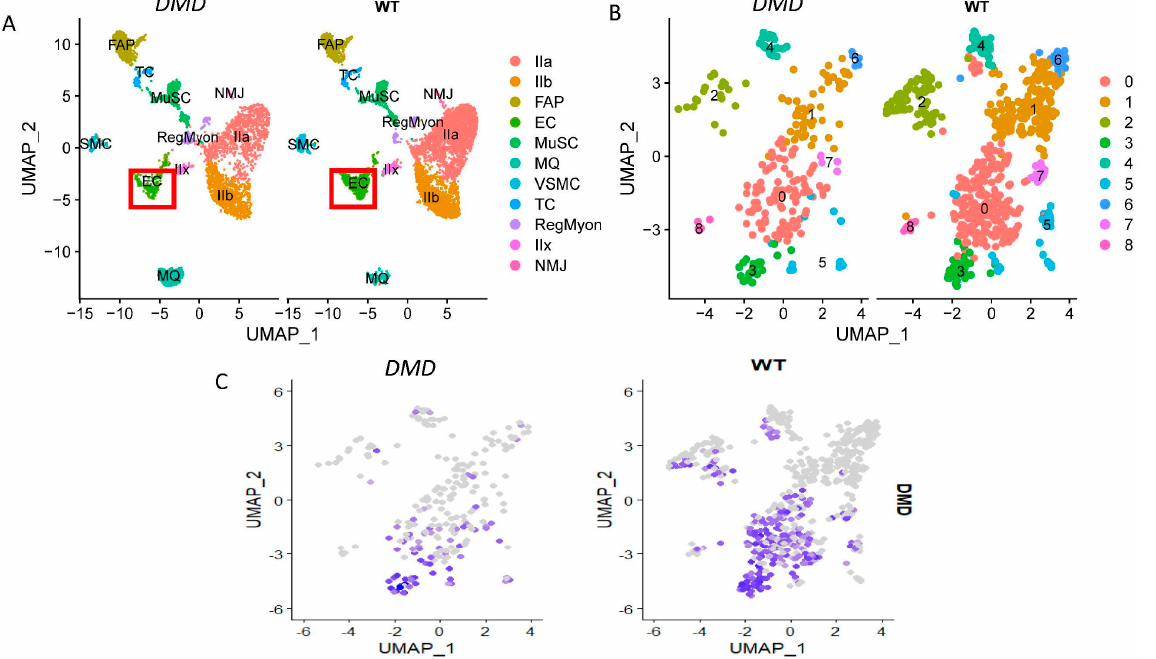
were visualized in low-dimensional space with